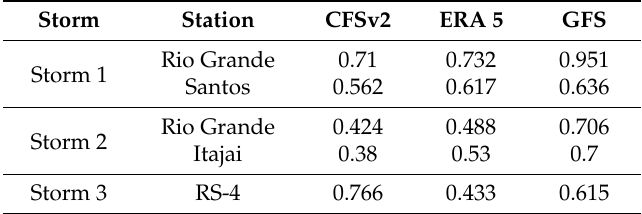
Table 4. Waves error metrics (RMSE in